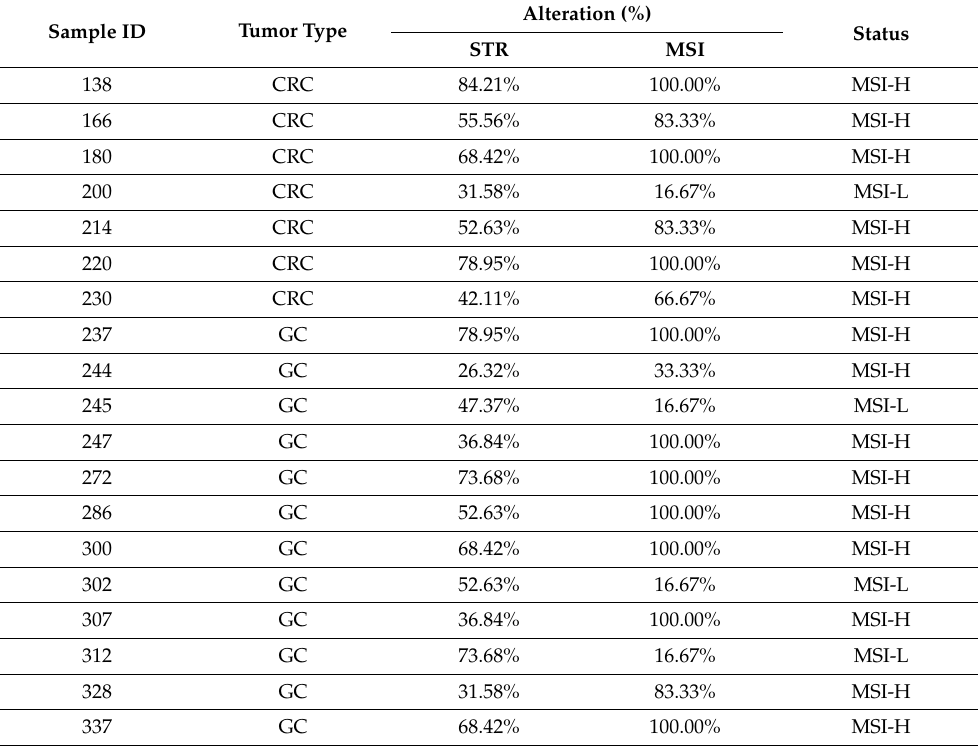
Table 3. STR and MSI status of all investigated MSI positive samples ( n =